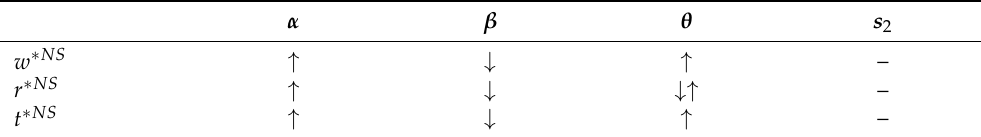
Table 7. The sensitivities of optimal operation policy to model parameters for Strategy NS. α β